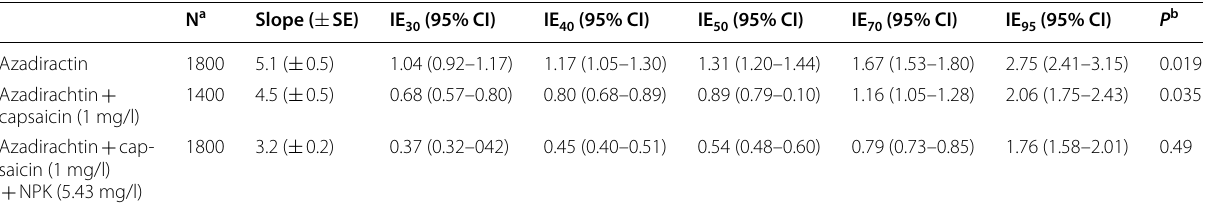
Table 4 Comparative toxicity of azadirachtin alone, azadirachtin combinations against susceptible strain IRD Aedes albopictus tested at the larval stage